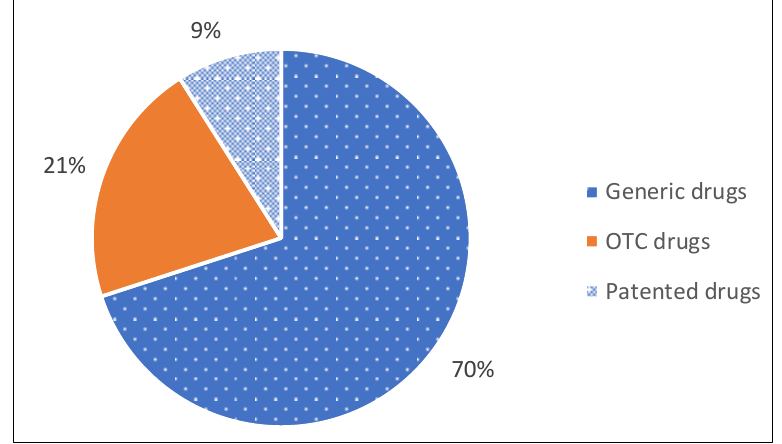
Figure 2. Indian Pharmaceutical Market by Segment (IBEF Pharmaceuticals 2019